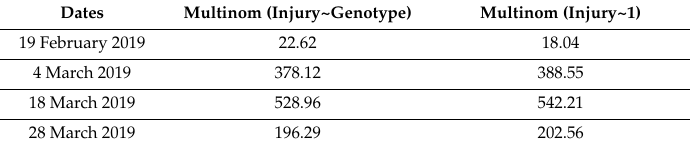
Table A2. Aikaike information criterion (AIC) for the two multinominal logistic models used to calculate the predicted probability of O 3 injury of Phaseolus vulgaris . The model with the lowest AIC is the optimal model. Models di ff ering in > 2 AIC from the optimal model have little empirical support.